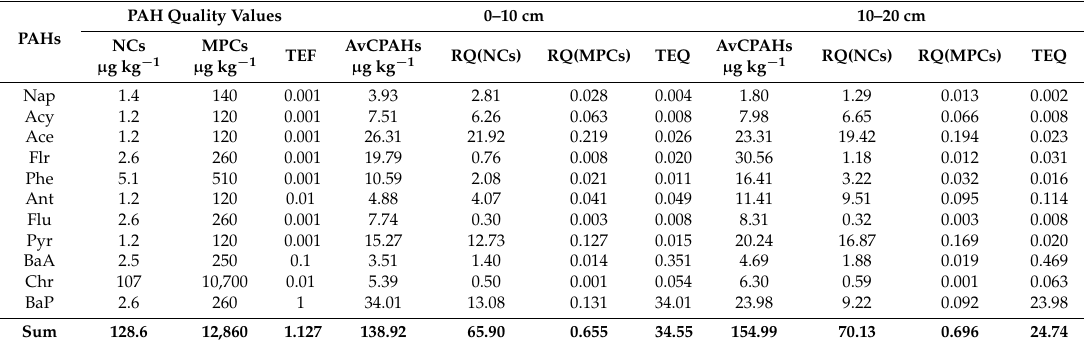
Table 6. Computed Risk Quotient (negligible concentration and maximum permissible concentration) and Toxicity Equivalency Quotient Values of